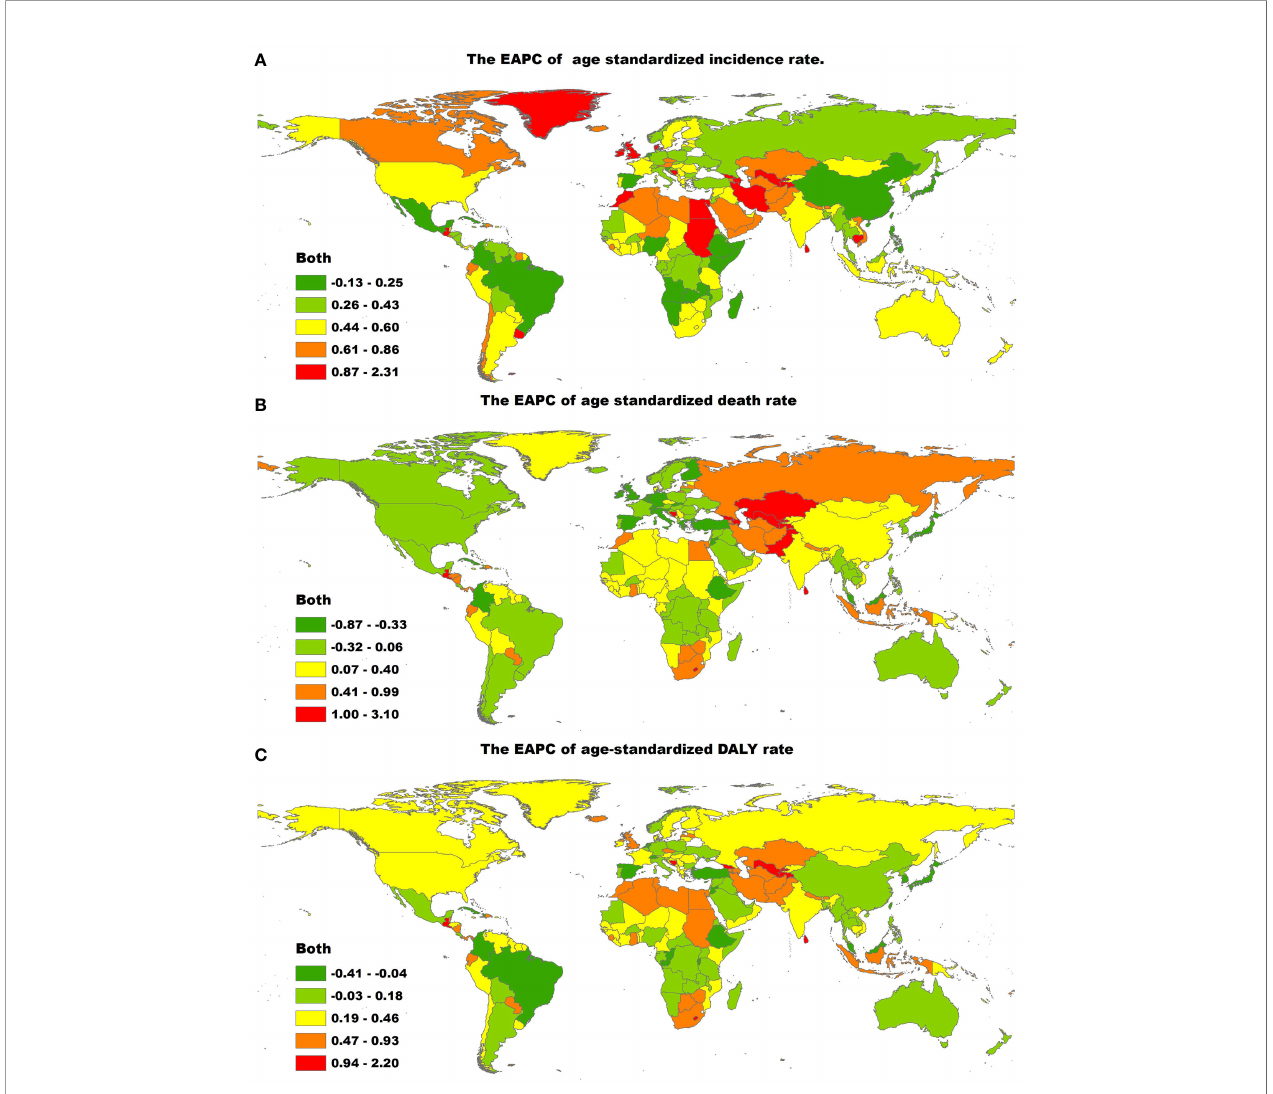
FIGURE 2 | The global EAPC of T2DM age-standardized rates from 1990 to 2019, by countries. (A) The EAPC of age-standardized incidence rate. (B) The EAPC of age-standardized death rate. (C) The EAPC of age-standardized DALY rate. EAPC, estimated annual percentage change; ASIR, age-standardized incidence rate; ASDR, age-standardized death rate; DALY, disability adjusted